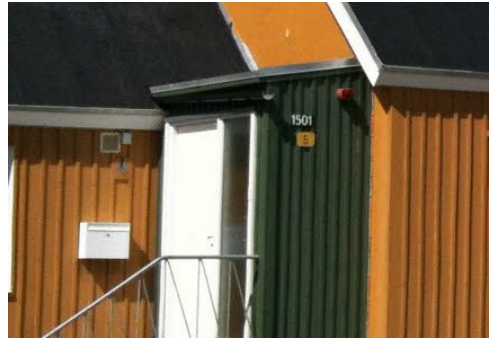
Figure 1: House number and B-number plate on the house in Greenland, Nuuk (Connie Maria Westergaards rejseblog, 2010)